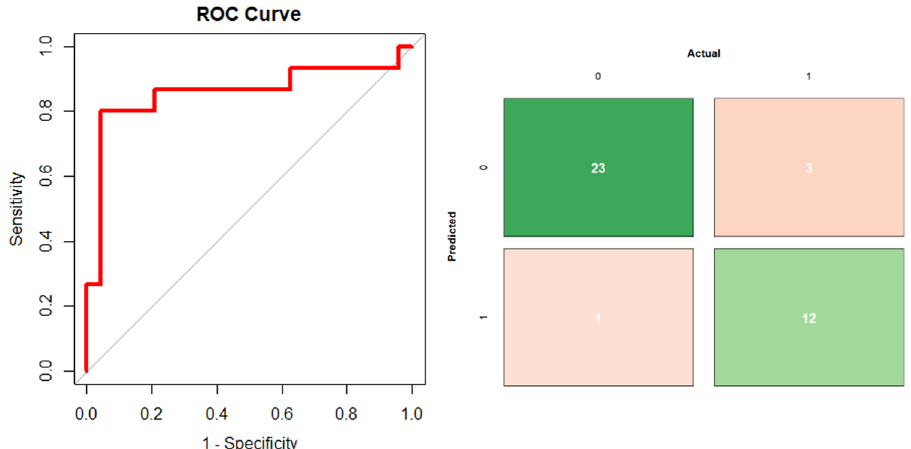
Figure 1. Assessment of model performance. The model achieved an Accuracy/AUC of 0.897/0.879 on the test set (left panel). In the confusion matrix (right panel), 0 indicates none-to-mild EPVS and 1 indicates moderate- to-severe EPVS. Out of 39 samples, there were 3 false positives and 1 false